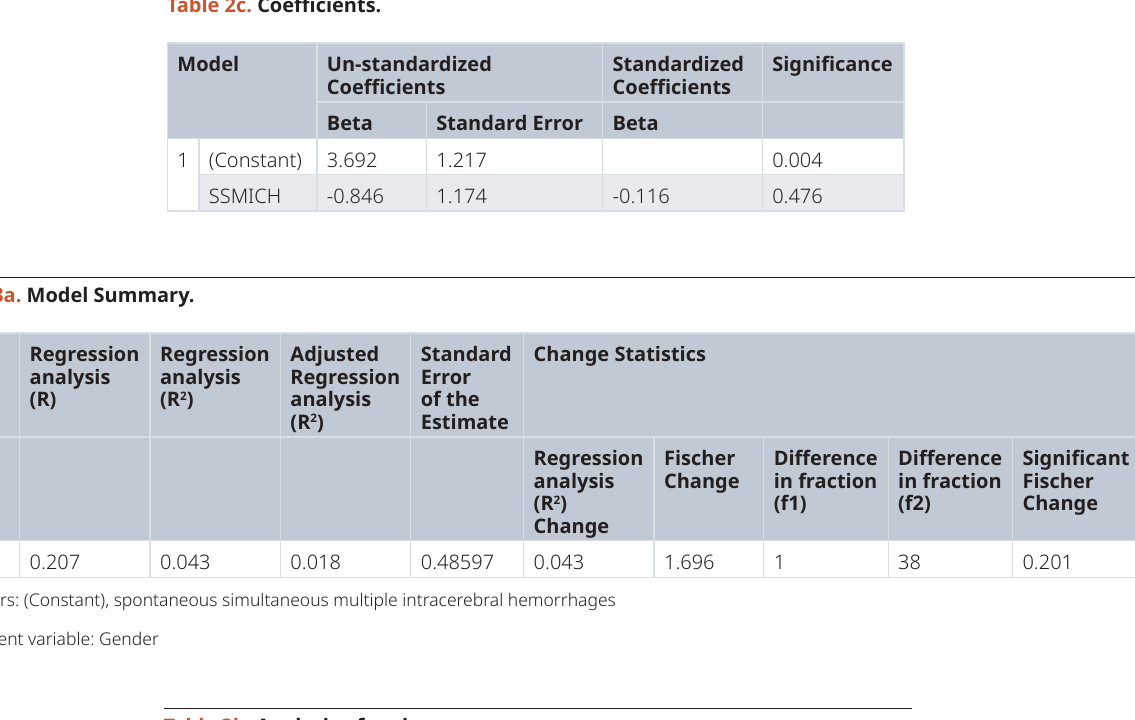
Table 3b. Analysis of variance.